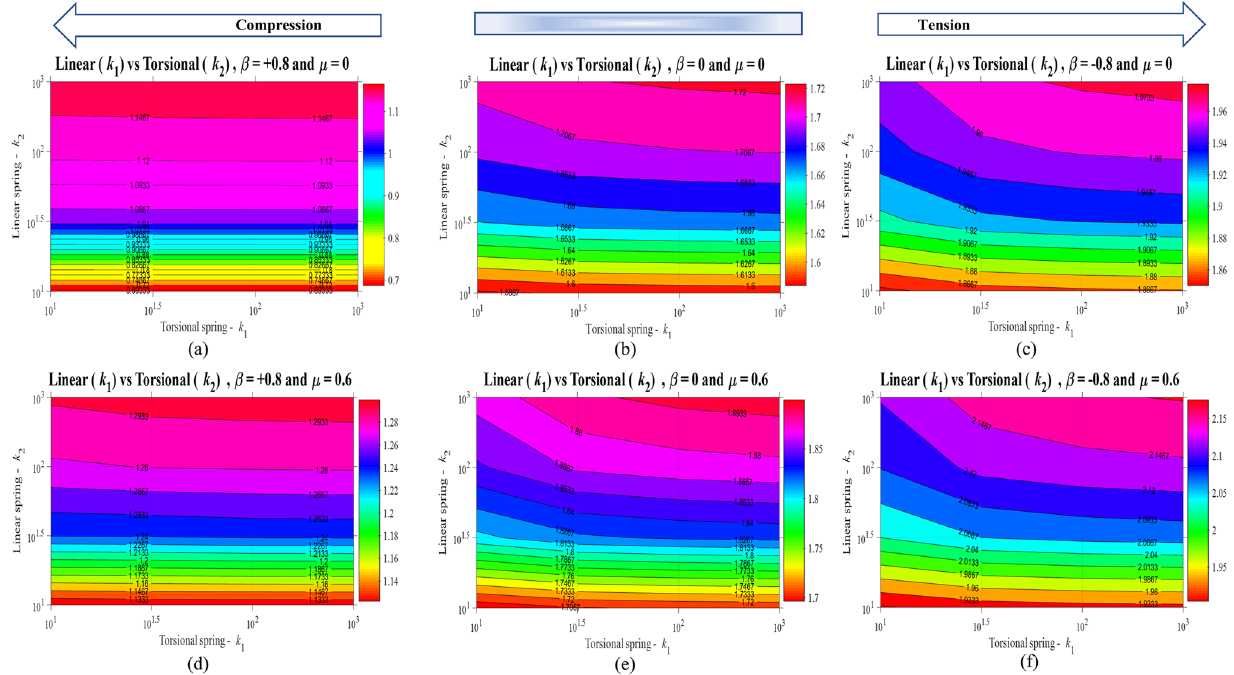
Fig. 7 Contour plots for torsional ( 𝜅 1 ) vs. linear spring ( 𝜅 2 ) with axial load ( 𝛽 2 ) and small scale-effects ( 𝜇 )